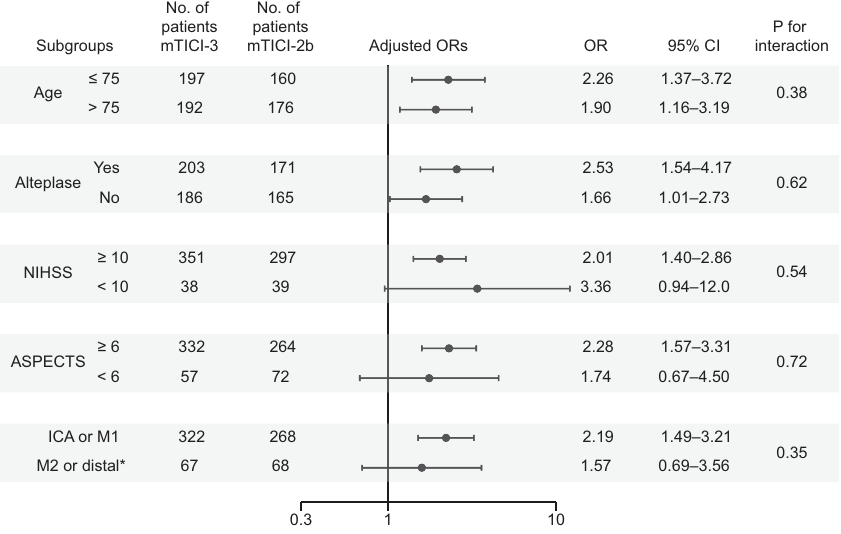
Figure 2. Adjusted odds ratios (ORs) of complete reperfusion (mTICI-3) for favorable outcome according to baseline characteristics. Adjusted for age, sex, NIHSS score, ASPECTS, target occlusion location (ICA, M1, or the other), intravenous alteplase administration, and onset-to-reperfusion time. * Five patients with anterior cerebral artery occlusion are included. NIHSS, National Institutes of Health Stroke Scale; ASPECTS, Alberta Stroke Program Early Computerized Tomography Score; CI, confidence interval; ICA, internal carotid artery; mTICI, modified thrombolysis in cerebral infarction; M1, the horizontal segment of the middle cerebral artery; M2, the insular segment of the middle cerebral artery.